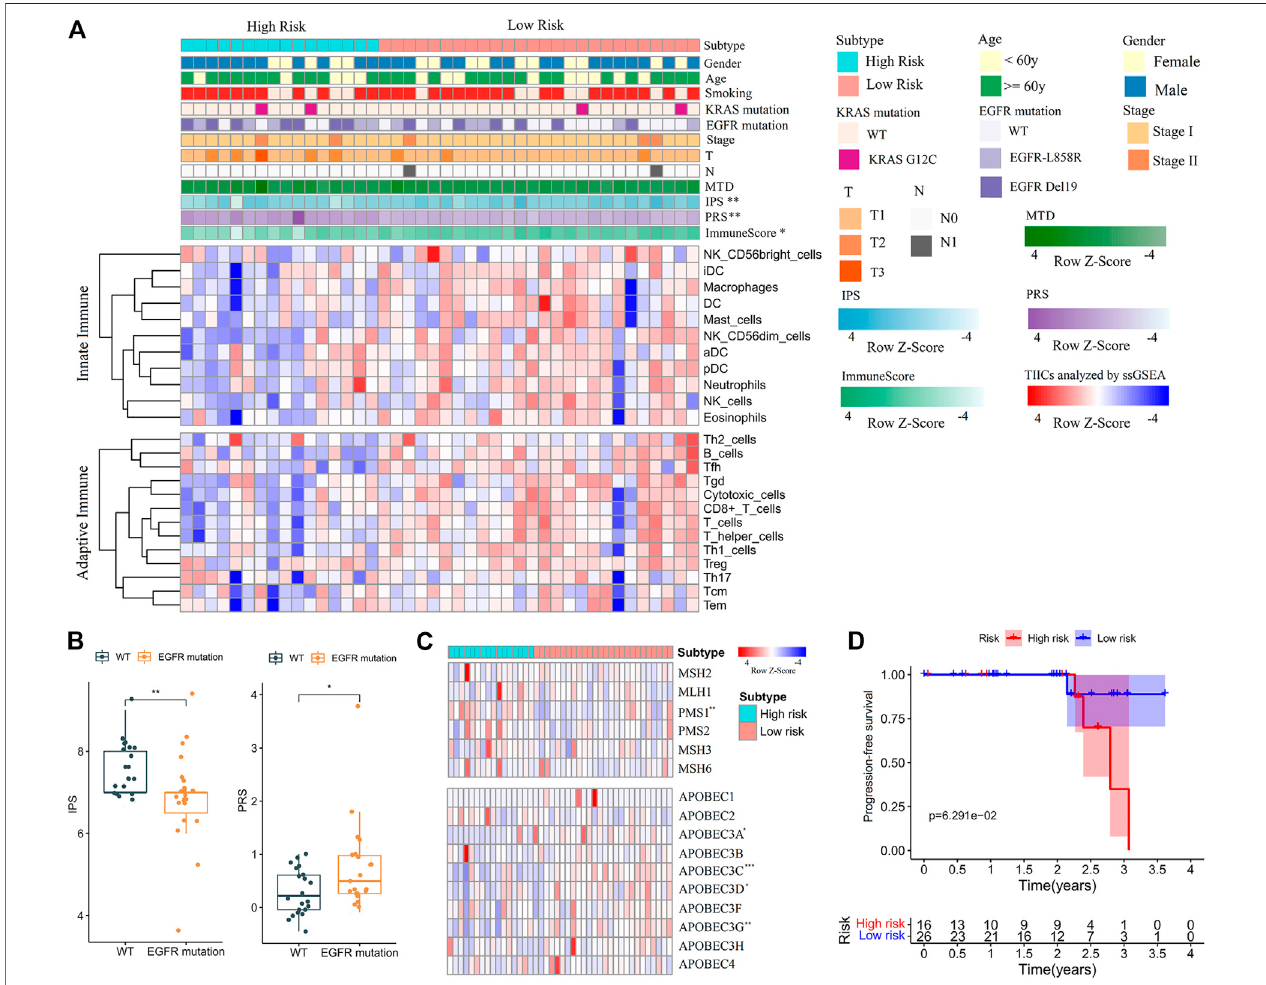
FIGURE 6 | Feature analysis and PFS comparisons of NJDT patients in different PRS subgroups. (A) Comparison of the variables between high- and low-risk patients.Fisher ’ sexacttestwasusedforcategoricalvariables:sex,age,smoking,KRASmutation,EGFRmutations,tumorsize(T),lymphnodemetastasis(N).Wilcoxon test was used for continuous variables: maximum tumor diameter (MTD), IPS, PRS, Immune Score, and TIICs. (B) Comparisons of IPSs and PRSs between EGFR mutation and wild-type patients. (C) Heatmaps of MMR and APOBEC genes in high- and low-risk patients. (D) Comparisons of PFS between high- and low-risk